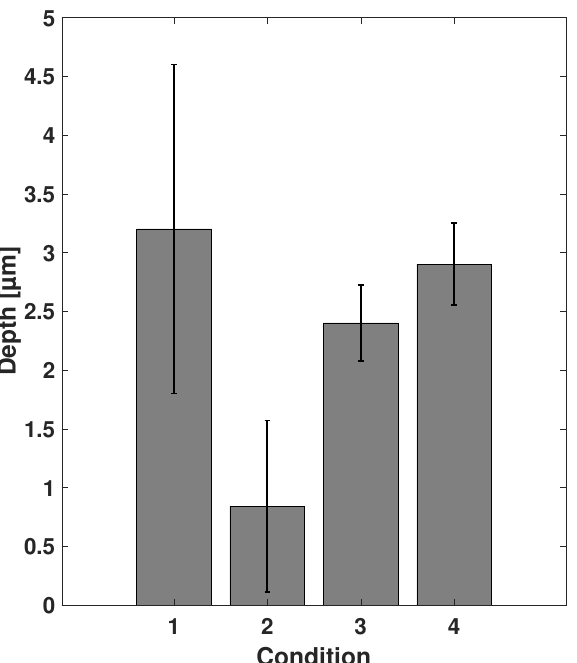
Figure 9. Average etch depths of zone plates on different Si chips processed at conditions C1–C4 for 9 min. The error bars indicate the depth variation between different